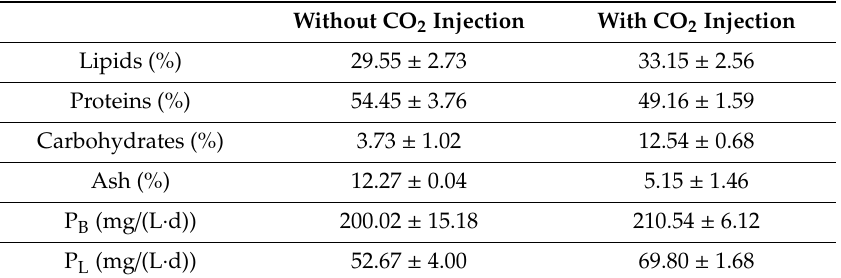
Table 3. E ff ect of CO 2 injection on biomass composition and Table 3. Effect of CO 2 injection on biomass composition and productivities.